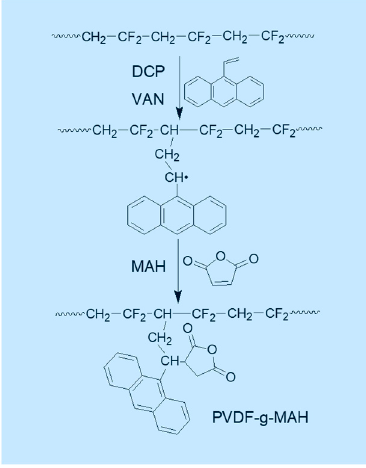
Scheme 2. Reaction mechanism of free-radical-initiated grafting of MAH onto PVDF in the presence of